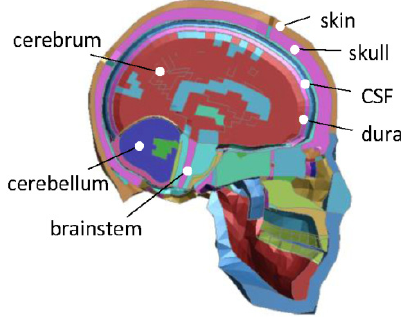
Figure 1. THUMS–head FE model. Figure 2. Three-layer structures of skull.